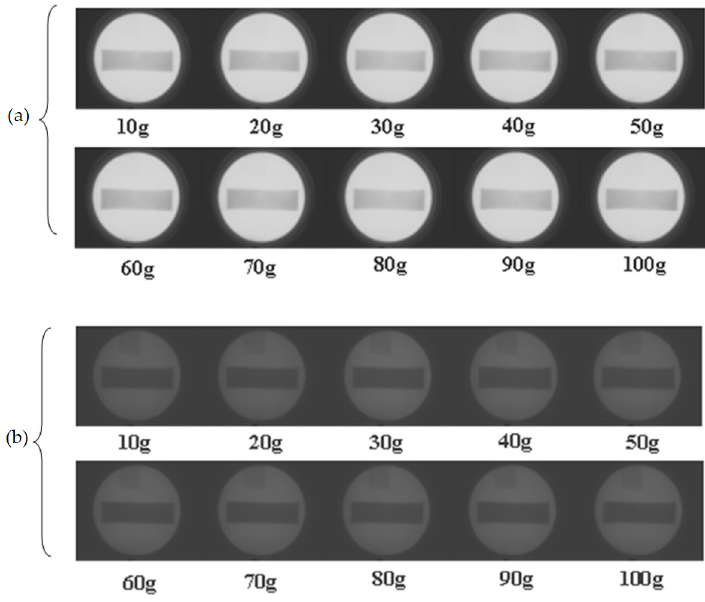
Figure 10. Calcium phantom.